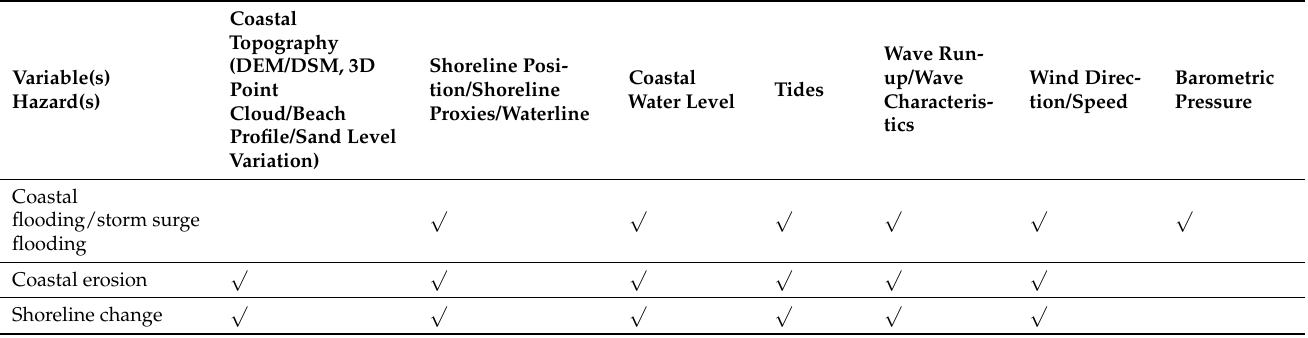
Table 6. Climate-induced coastal hazards and the relevant variables monitored.